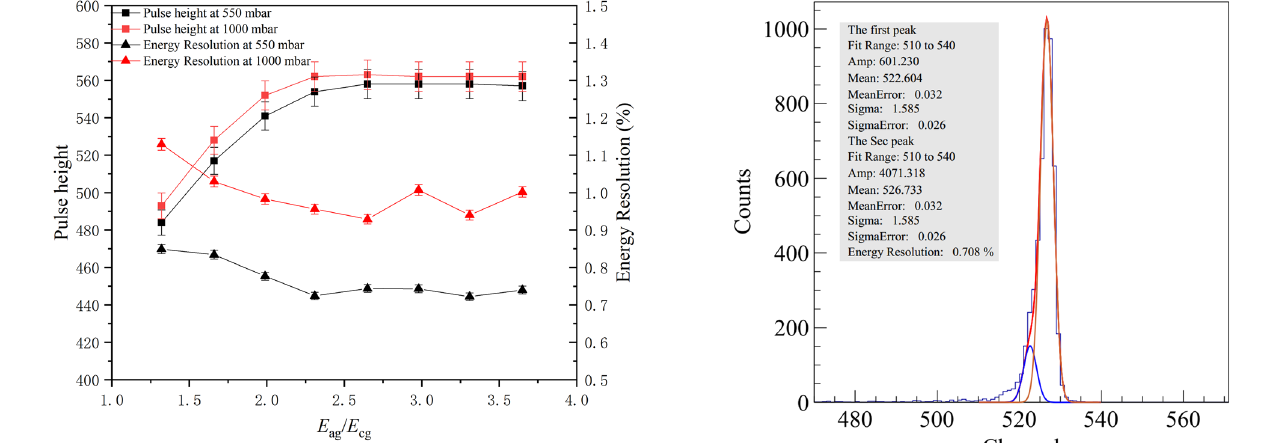
Fig. 3 Energy spectrum obtained with an 241 Am source. The red line (on top of the data) represents the total adjustment to the data taking into account the known alpha peak energies and branching ratios. The orange and blue lines, shown as two single Gaussians, represent the two different alpha contributions with branching ratios of 84.8% and 13.1%,